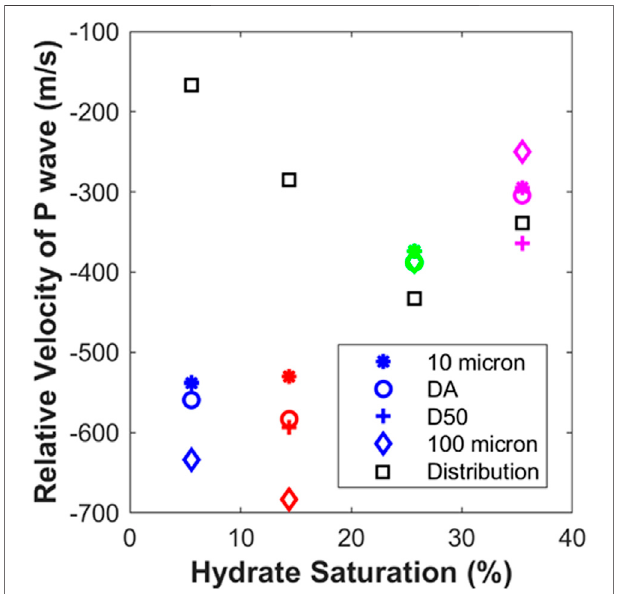
FIGURE 11 | Effect of gas bubble size and distribution on S wave velocity during hydrate formation in porous sediment.